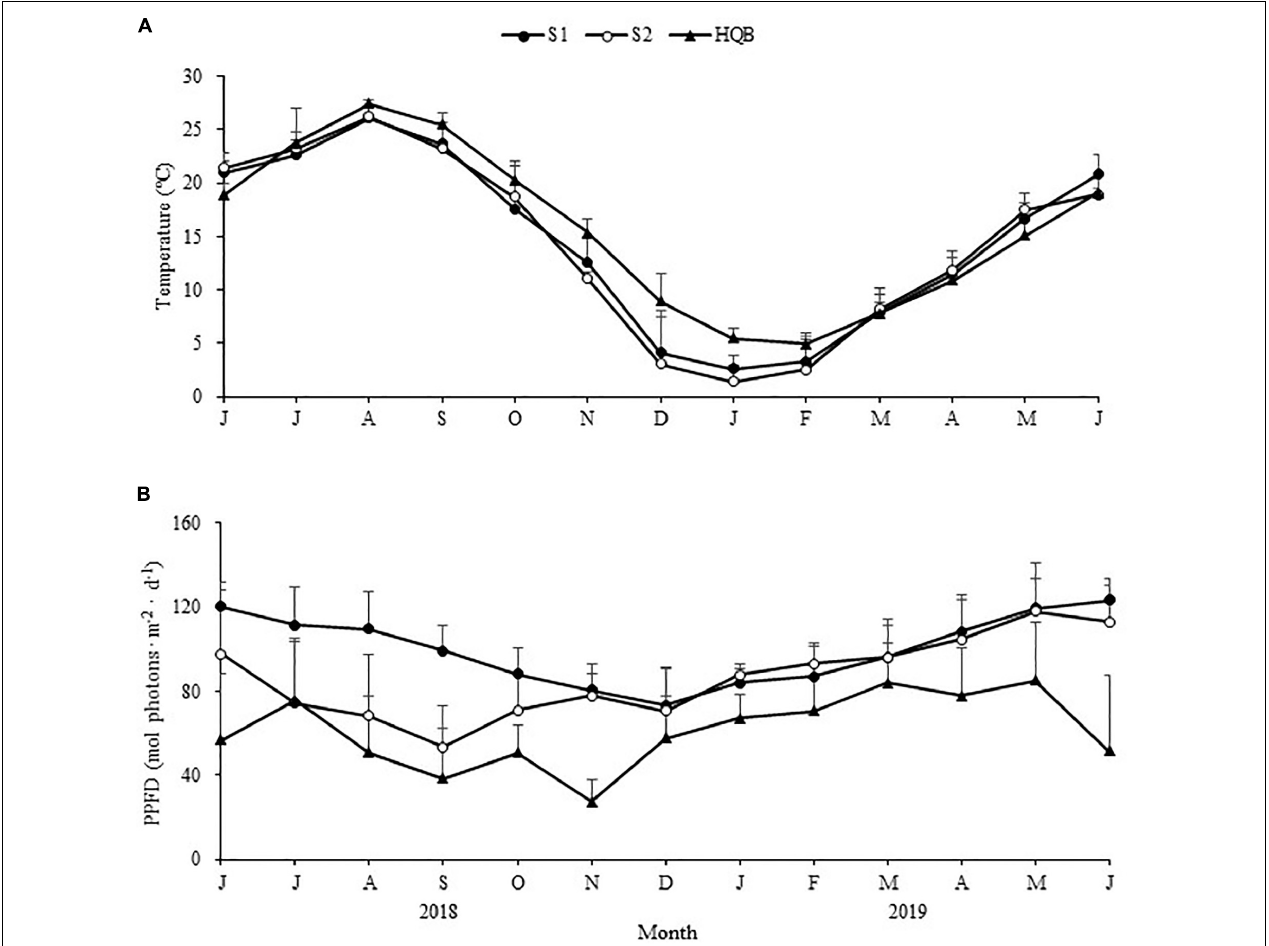
FIGURE 2 | Seasonal changes in temperature (A) and light intensity (B) in the study sites from June 2018 to June 2019 (Huiquan Bay is represented by H1 and H2). Values are mean ± SD.